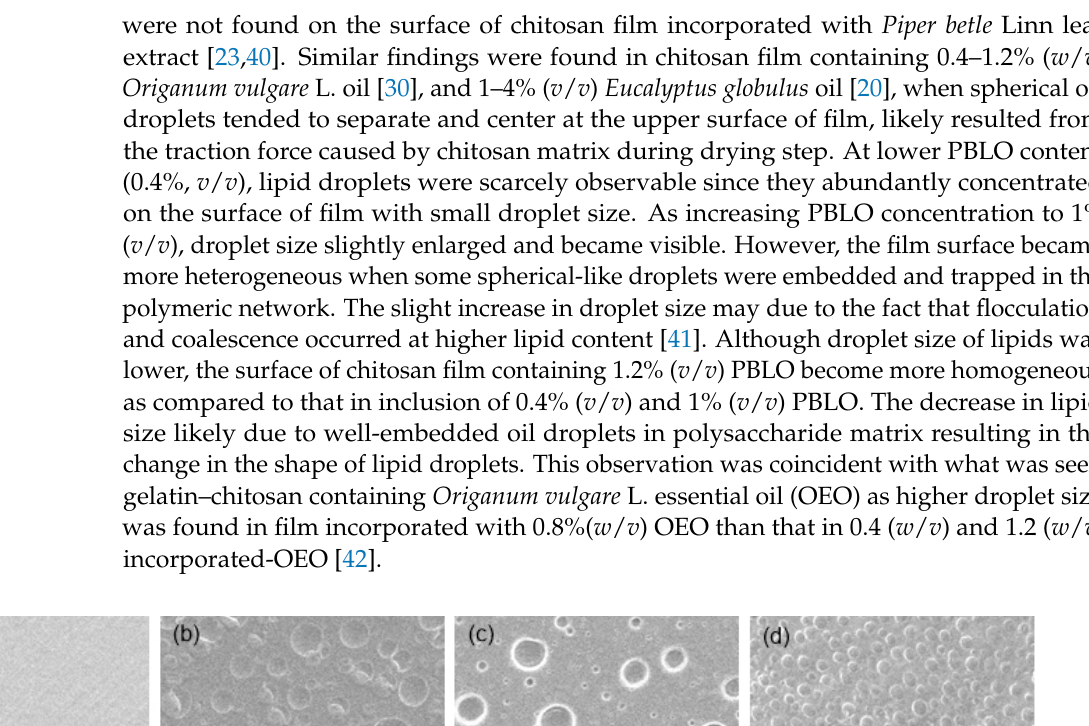
Figure 5. UV ‐ Vis analyses of the pCS, pCS ‐ 0.4PBLO, pCS ‐ 1PBLO, and pCS ‐ 1.2PBLO.